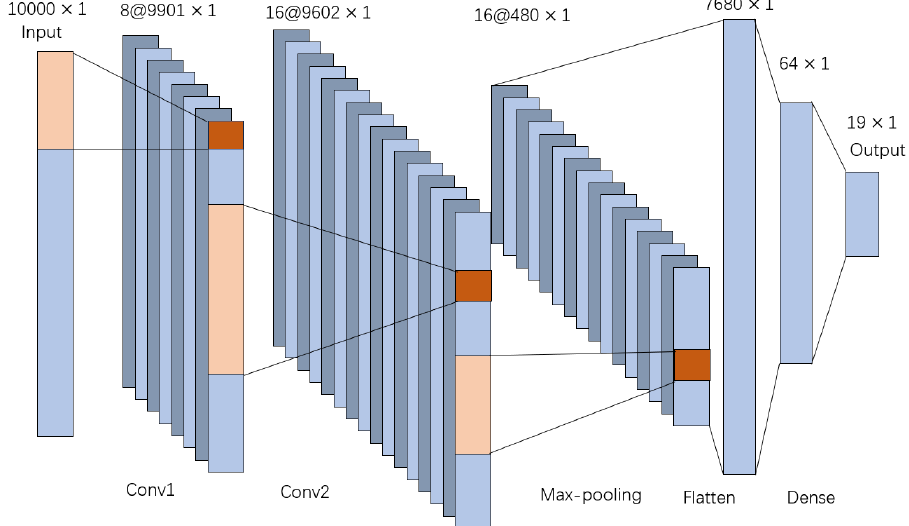
Figure 5. The process of the convolutional neural network (CNN).